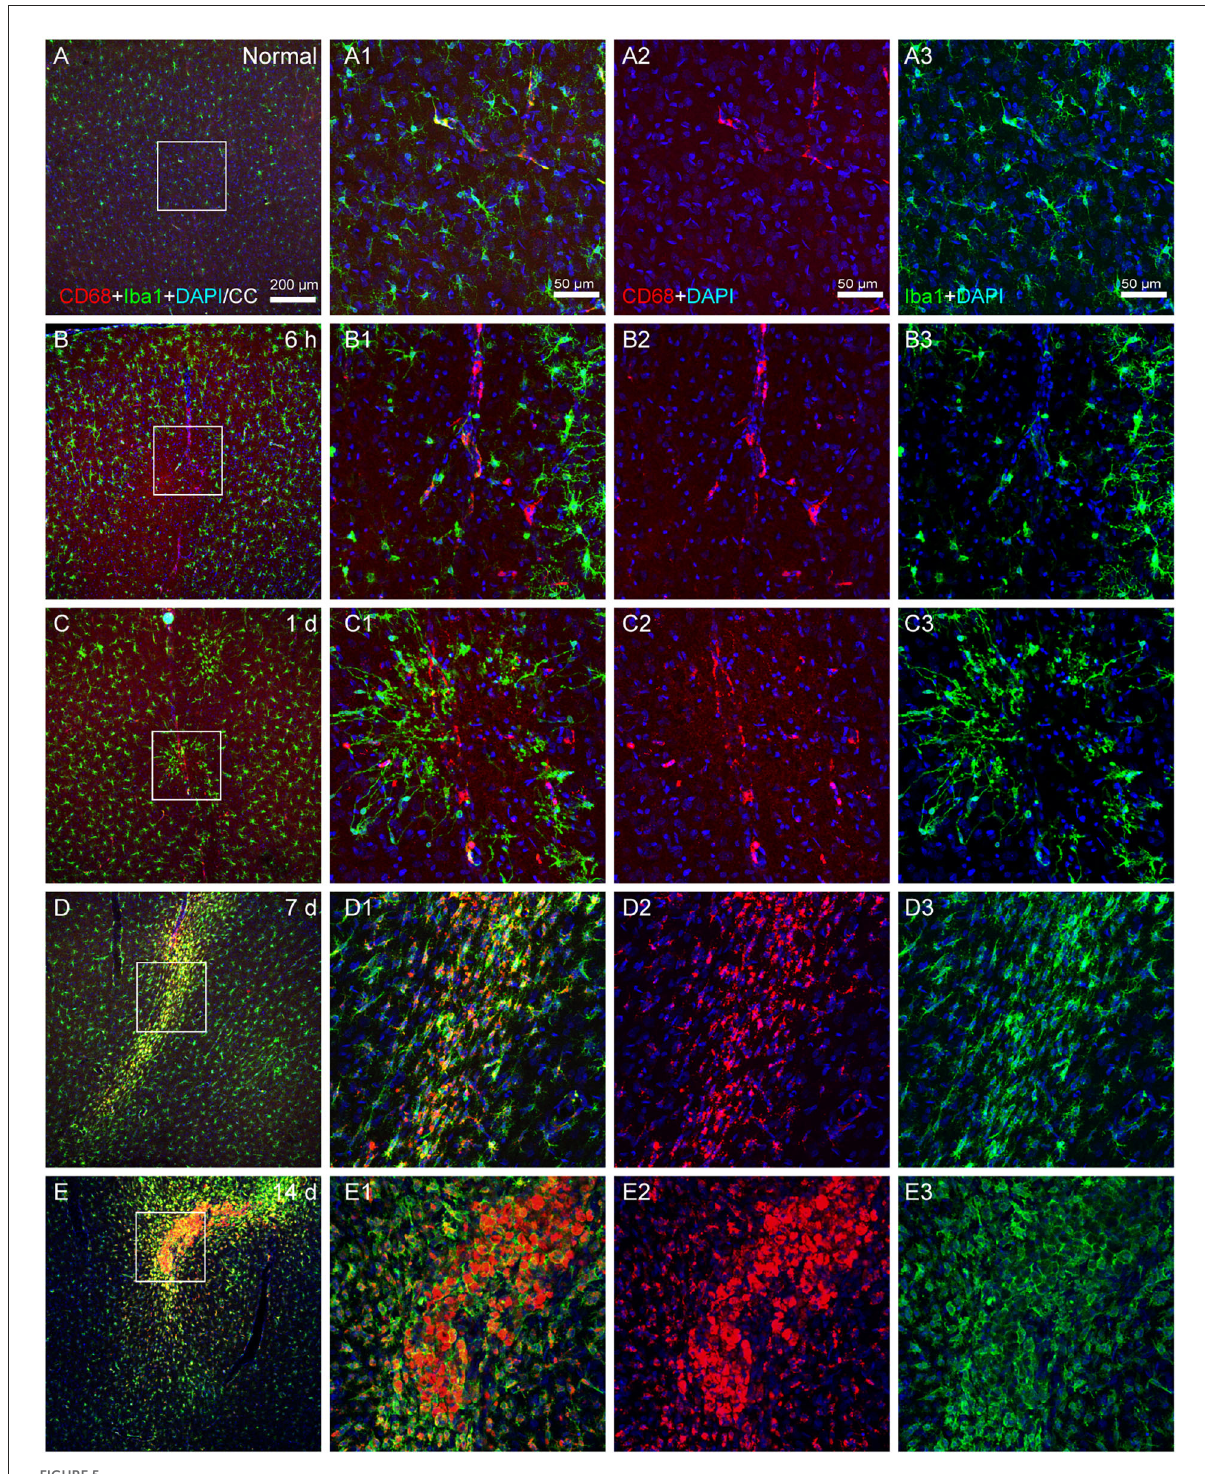
FIGURE5 The activated state of microglia. (A–E) The representative photographs from the cerebral cortex at the group of normal, 6h, 1, 7, and 14 days, showing CD68 (red, Alexa Fluor 594)-labeled and Iba1 (green, Alexa Fluor 488)-labeled cells. (A1–E1) Magnified photographs from the box-indicated regions in (A–E) show the details. (B–E) Following surgery, microglial phenotypes with phagocytic activity could be identified at 6h, 1, 7, and 14 days. The alteration in all model rats presented in a similar pattern ( n = 7). The green dot in (C) was lodged in